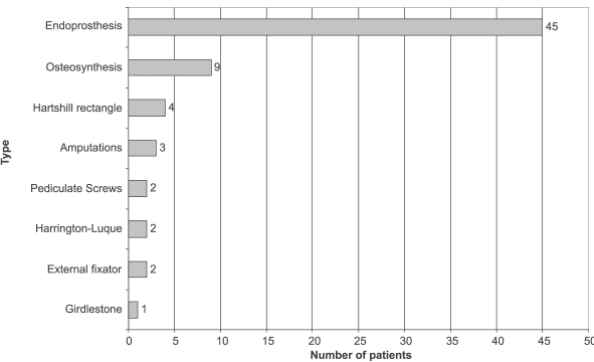
Figure 6- Distribution according to type of